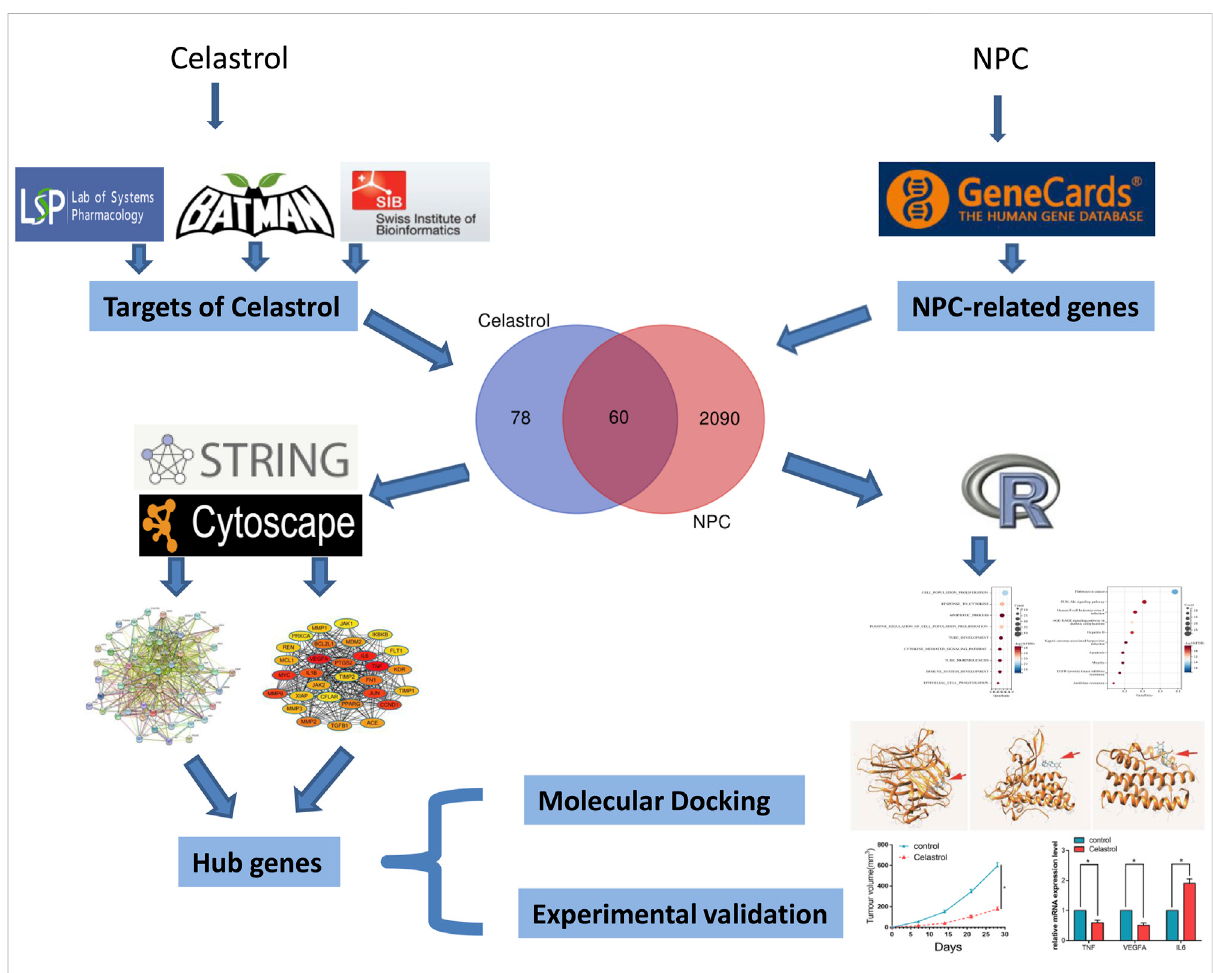
FIGURE 1 The fl owchart of this study. The target genes of Celastrol were fi rstly obtained by screening the TCMSP, BATMAN-TCM, and Swisstarget databases; then NPC-related genes were obtained by the Genecards database; the two gene sets wereintersected to obtain 60 genes. These